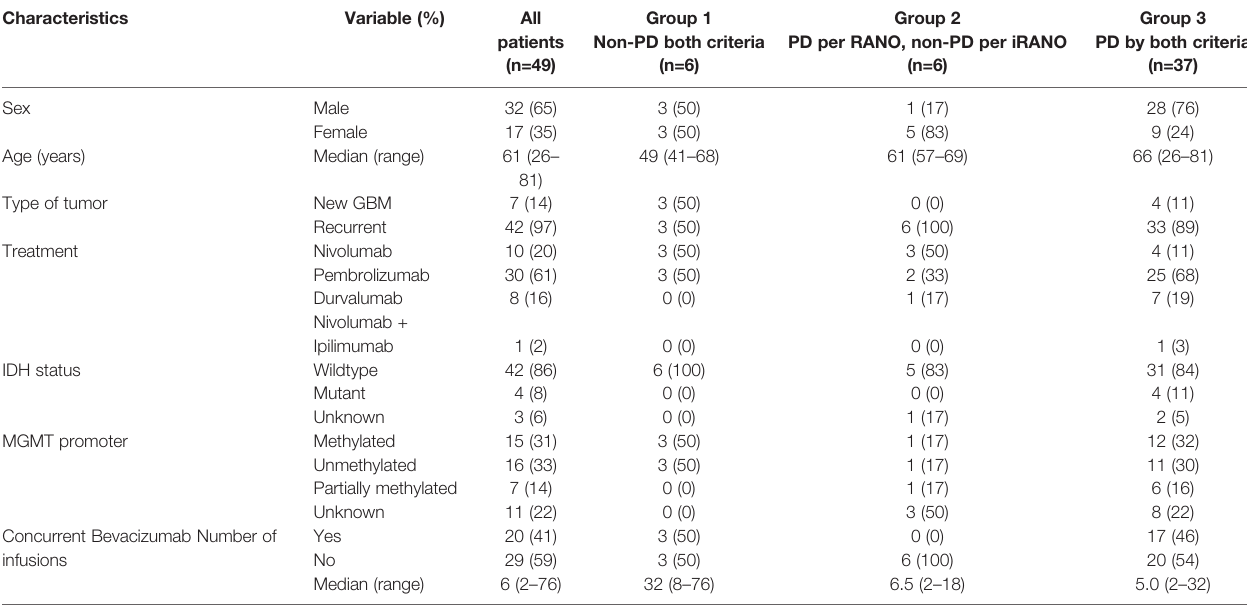
TABLE 1 | Patient demographics and clinical